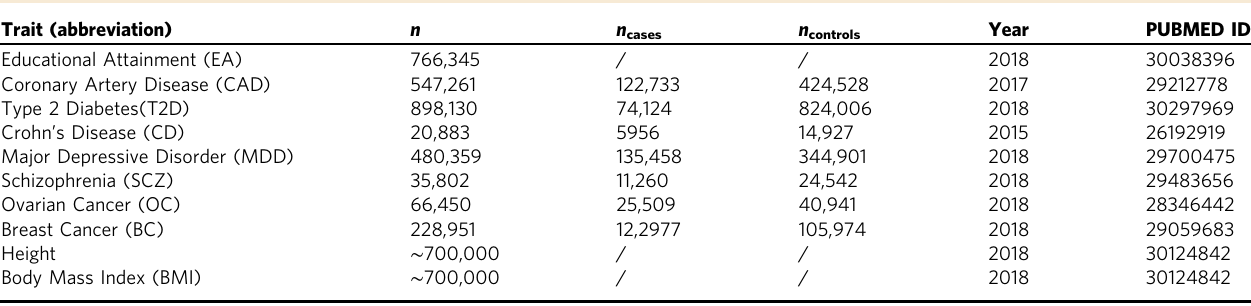
Table 4 A summary of the 10 published GWAS summary data sets used in this